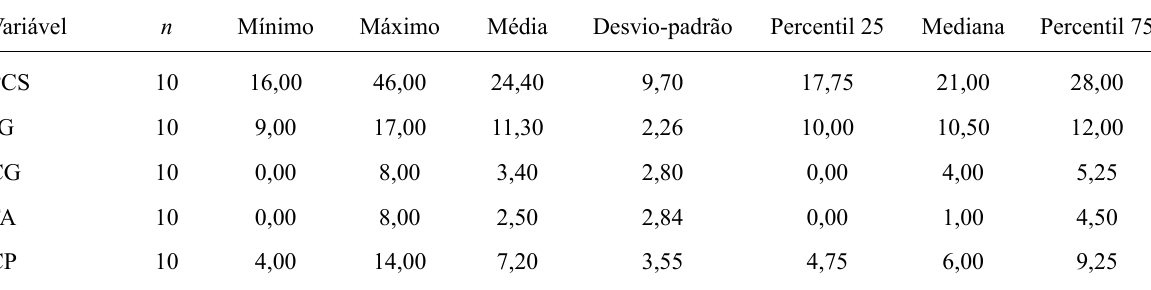
A Tabela 3 apresenta as medidas centrais da Prova de Consciência Sintática –